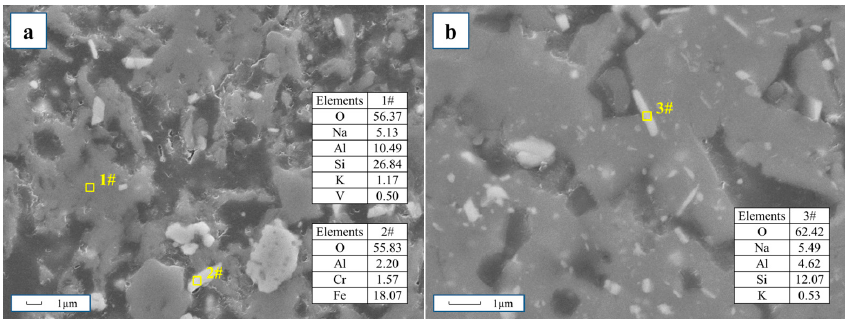
Figure 5. The SEM pattern of NaCl-Na 2 SO 4 composite salt leaching residue. ( a ) The large white particles in the melt, ( b ) The small white particles in the melt. 1#—melt, 2#—spinel, and 3—albite.